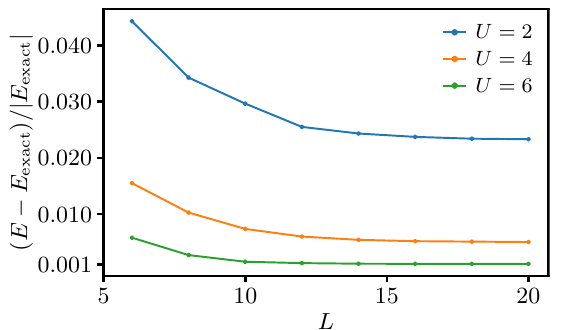
FIG. 5. Scaling of the GMPS+U ethod when changing system size L —the relative error in energy versus the total length L of spinful sites for the FH model at U = 2, 4, 6 and ν = 1 block size B = 6.